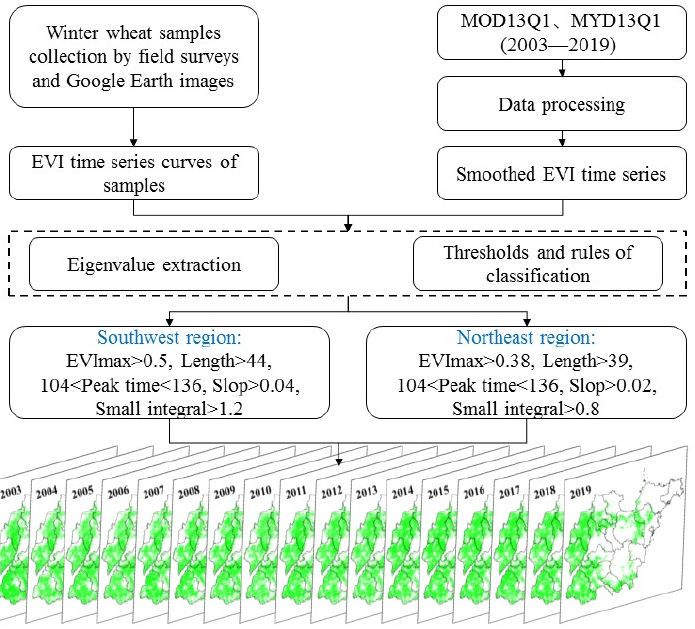
Figure 2. Flowchart for extracting the winter wheat planting area in Shandong